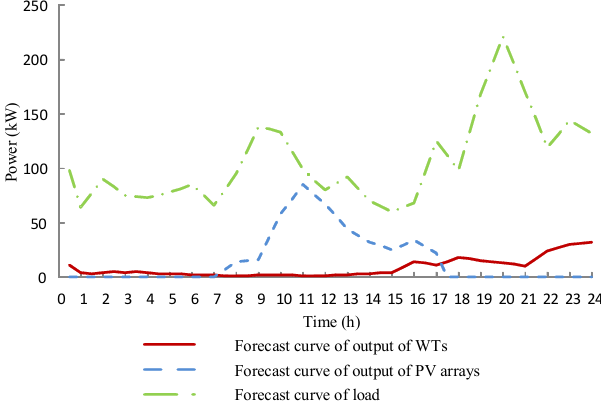
Figure 5. Forecast curves of the load and output of WTs and PV arrays.